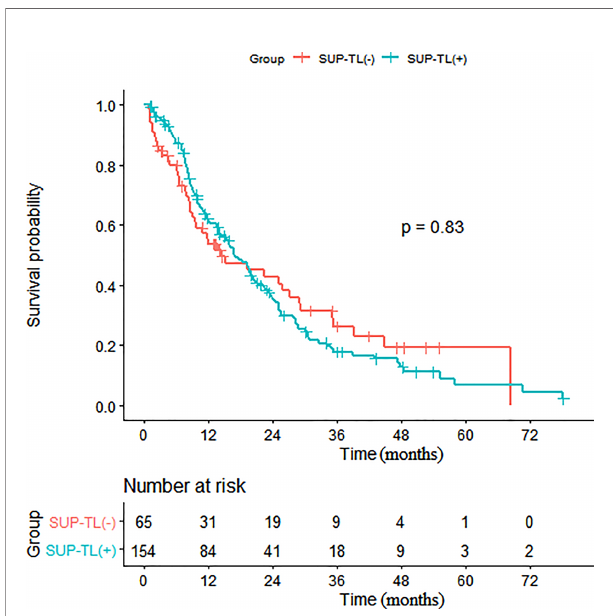
FIGURE 4 | Kaplan-Meier survival analysis of patients with and without SUP- TL. (SUP-TL, supraphrenic total